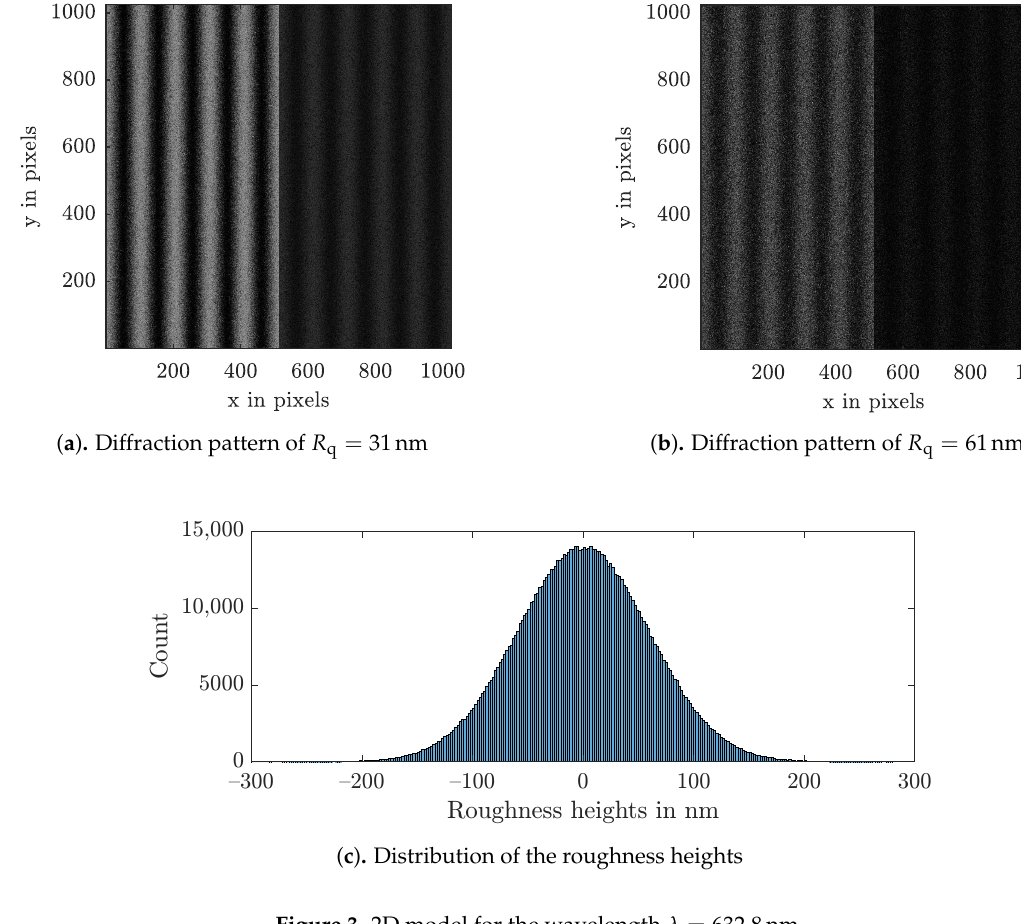
Figure 3. 2D model for the wavelength λ =